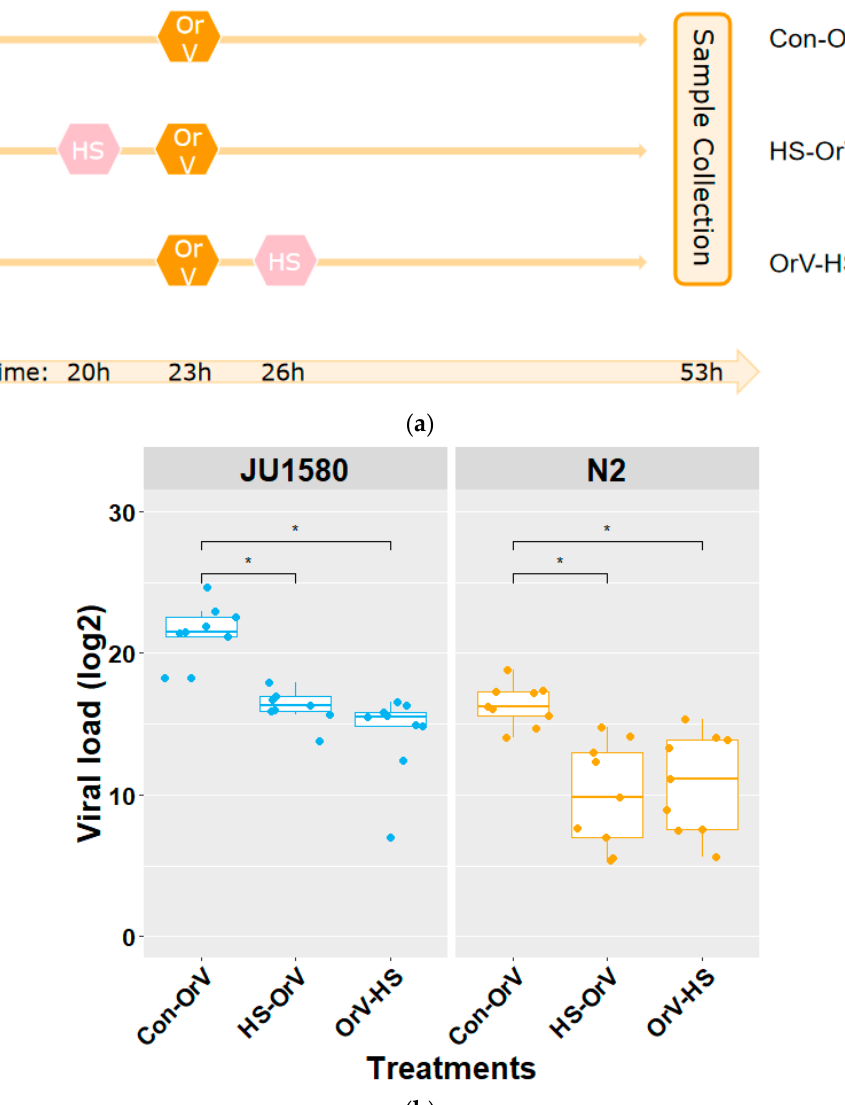
Figure 1. Viral load of JU1580 and N2 under combined HS and OrV infection ( a ) and timeline of the three experimental treatments. ( b ) The viral load of JU1580 and N2 under heat stress (HS). Con-OrV: Orsay virus infection; HS-OrV: HS before Orsay virus infection; OrV-HS: HS after Orsay virus infection. Dots: infected biological replicates. *: significantly different, Tukey HSD test, p < 0.05.